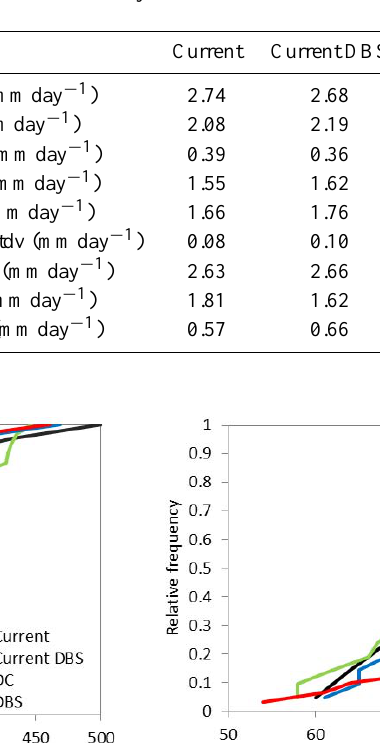
Table 4. Precipitation and reference ET in the Vidaa catchment area for the current and the future scenario, using the DC method and the DBS method respectively. Note that the term “summer” is in this study defined as the months of May, June, July, and August.